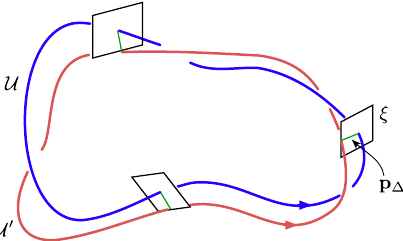
FIG. 8. The self-linking number for transverse umbilic loops. The red curve U 0 is formed by pushing U along an eigenvector field p Δ of Δ . The self-linking number is then computed as the linking number of U with U 0 . The umbilic must be transverse to ensure that U 0 does not cross U . Because the eigenvectors are degenerate on the umbilic, one evaluates p Δ on a line close to U , ˆ U , that has zero self-linking number with U . Such a line can be found by drawing an orientable surface whose boundary is U and pushing U into that surface. Note that, because eigenvectors are line fields, the self-linking number can be a half-integer, corresponding to p being nonorientable along the longitude of U